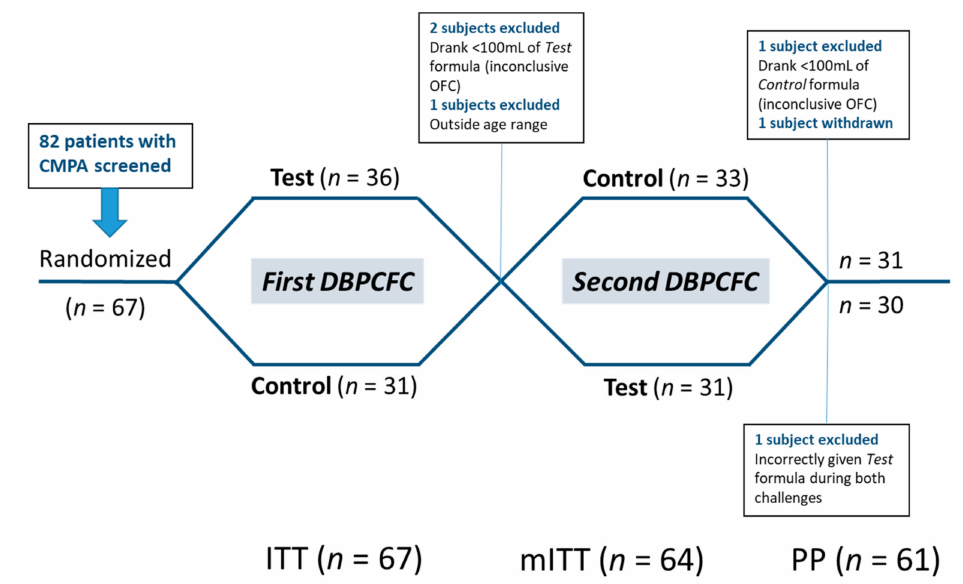
Figure1. Studyflowchart. Patientswereallocatedtoperformtwodouble-blind, placebo-controlledfood challenges (DBPCFC) with the Test and Control formula in randomized order. ITT—Intention-to-treat;